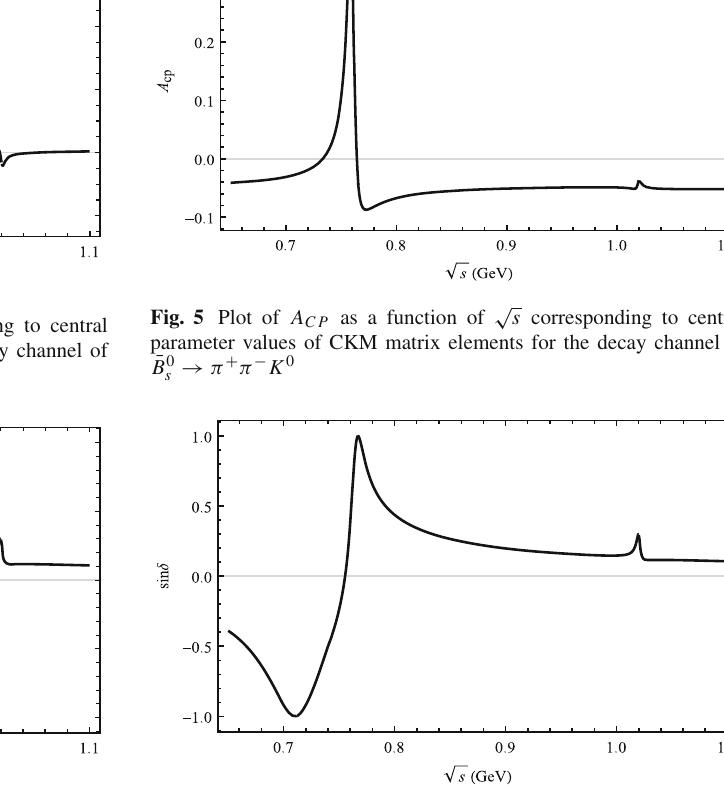
Fig. 3 Plot of sin δ as a function of parameter values of CKM matrix elements for the decay channel of ¯ B 0